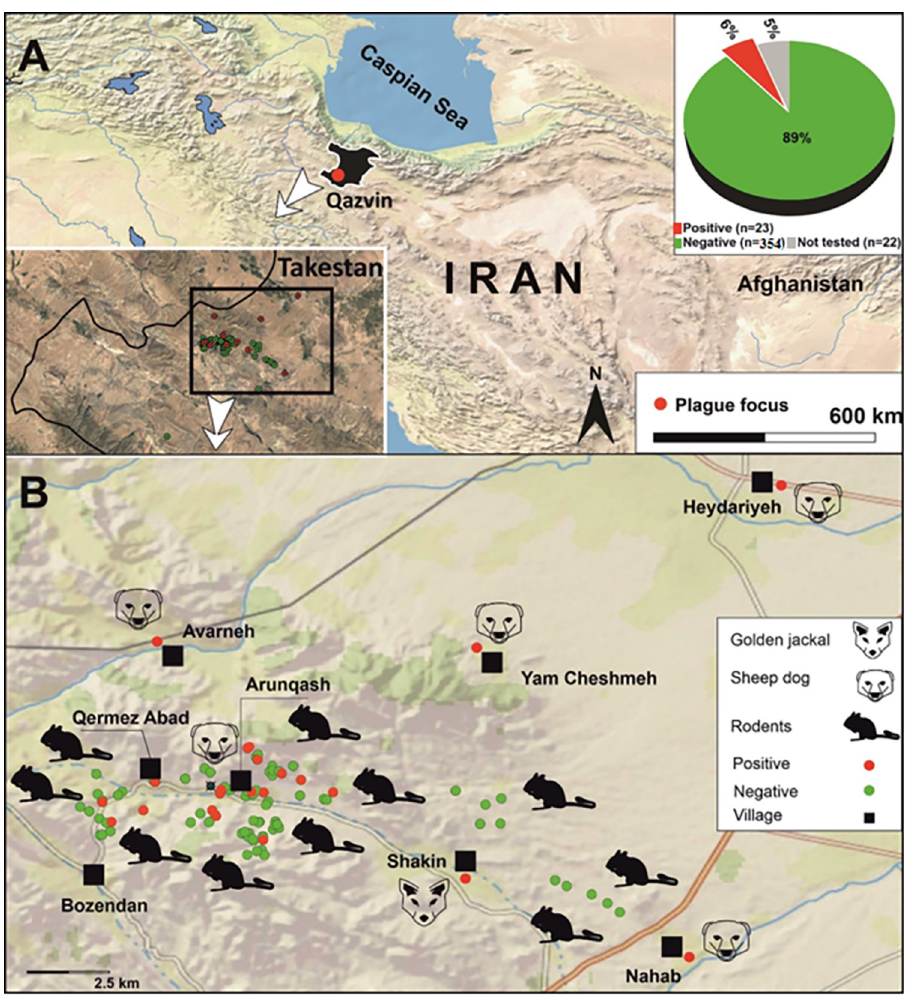
Fig 1. Map of the study area in Iran, A) the geographic position of Qazvin Province, the pi-chart on the right- hand shows the proportion of the captured and positive rodents, B) sampling sites for rodents, and carnivores in Takestan county; red circles show serologically positive cases. For both parts (A & B), used QGIS software, and the map layers were obtained from Natural Earth: https://www.naturalearthdata.com, all layers, and maps are public domain (http://www.naturalearthdata.com/about/terms-of-use/), and do not need permission for publication. The presented clip-arts in Fig 1 are drawn by authors using graphic design software (CorelDraw).